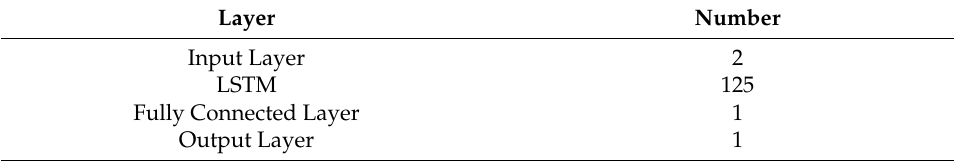
Table 3. Construction of the LSTM neural network model for SOH estimation.